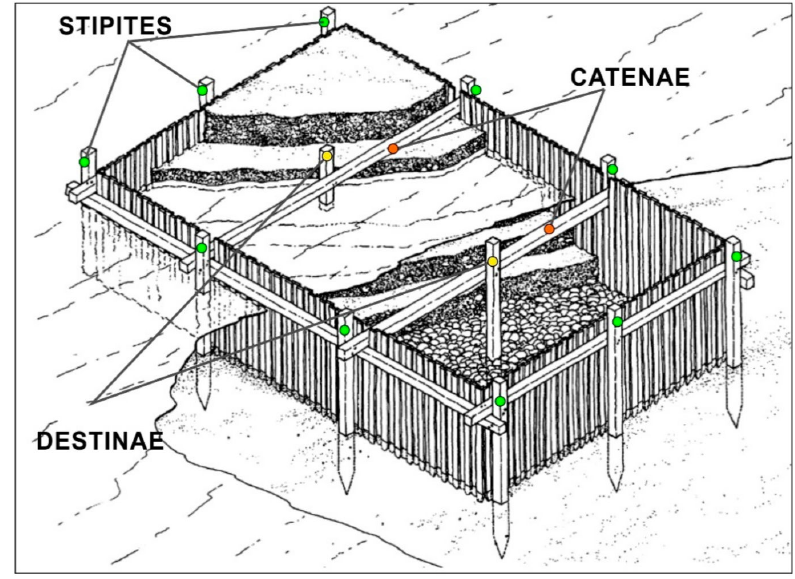
Figure 2. Vitruvius’ cofferdam for hydraulic concrete. Reconstruction (after